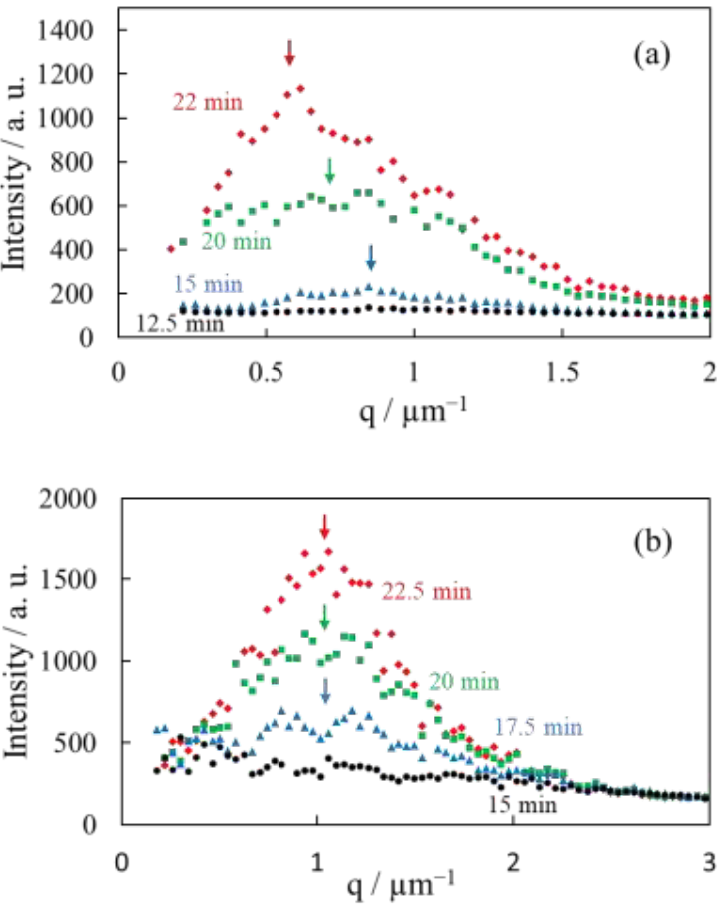
Figure 8. Hv light scattering profiles at an azimuthal angle of 45° during isothermal crystallization at 165 °C: ( a ) α -spherulite of neat PVDF; ( b ) γ -spherulite of PVDF/TBAHS. 165 ◦ C: ( a ) α -spherulite of neat PVDF; ( b ) γ -spherulite of